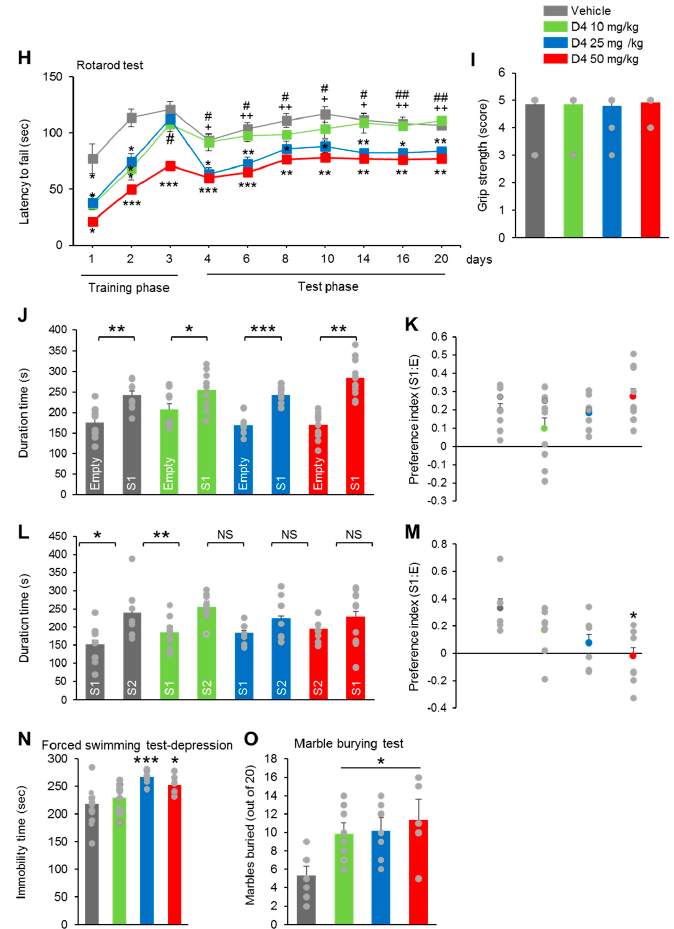
Figure 3. Prenatal D4 treatment induced behavioral deficits in adulthood. ( A ) In Morris water maze test, D4 − treated groups exhibit spatial learning disability. ( B ) Representative swimming paths of vehicle and D4 − treated mice during a probe trial. ( C – F ) Quantification of ( B ). D4 50 mg/kg group showed a slightly lower success in platform crossings and spent less time on platform. D4 − treated groups showed no change in the swimming distances and swimming speeds compared to vehicle group. ( G ) In novel test, vehicle and D4 10 mg/kg groups displayed more time approaching and in proximity to the novel object. However, D4 25 mg/kg and D4 50 mg/kg groups displayed recognitive impairment. ( H ) D4 − treated mice showed a decreased latency to fall during the rotarod test. ( I ) D4 − treated mice exhibited normal in grip strength test. ( J ) D4 − treated mice exhibited normal in social behavior in the three − chamber test. ( K ) D4 − treated group preference index was no different compared to vehicle group. ( L ) Moreover, unlike vehicle and D4 mg/kg groups, D4 25 mg/kg and D4 50 mg/kg groups displayed impaired social novelty recognition by demonstrating no preference for a novel mouse over a familiar mouse. ( M ) D4 50 mg/kg group preference index was markedly lower compared to vehicle group. ( N ) In the forced swimming test, D4 25 mg/kg and D4 50 mg/kg groups showed higher in the immobility time compared to the vehicle group. ( O ) In the marble − burying test, compared with vehicle group, D4 − treated groups showed a signifi- cantly greater number of marble burying bouts. Data represent mean ± SEM. Statistical significance was determined by one − way ANOVA with Bonferroni correction for multiple comparison test or two-tailed Student’s t test to compare two groups. * p < 0.05 vs. vehicle, ** p < 0.01 vs. vehicle, *** p < 0.001 vs. vehicle, # p < 0.05 D4 10 mg/kg vs. D4 50 mg/kg, ## p < 0.01 D4 10 mg/kg vs. D4 50 mg/kg, ### p < 0.001 D4 10 mg/kg vs. D4 50 mg/kg, + p < 0.05 D4 25 mg/kg vs. D4 50 mg/kg. ++ p < 0.01 D4 25 mg/kg vs. D4 50 mg/kg, +++ p < 0.001 D4 25 mg/kg vs. D4 50 mg/kg.